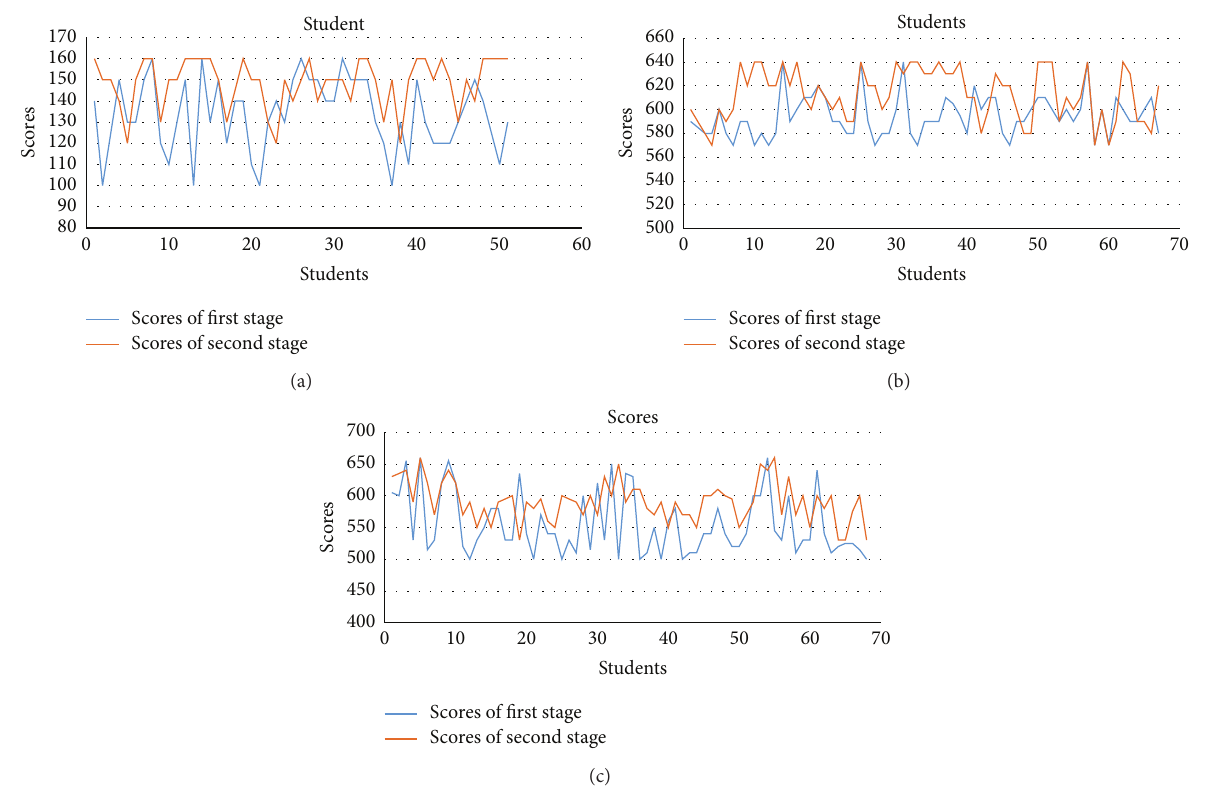
Figure 18: (a) is the result of G1 students. (b) is the result of G3 students. (c) is the result of G5 students.